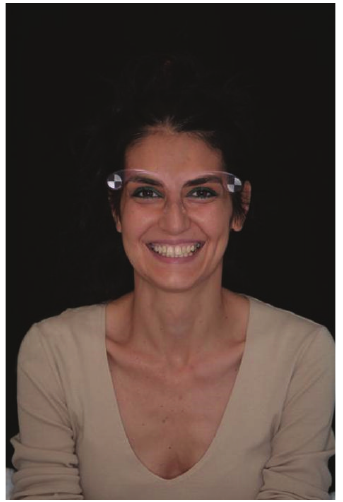
Figure 2: Initial clinical case extraoral photography.